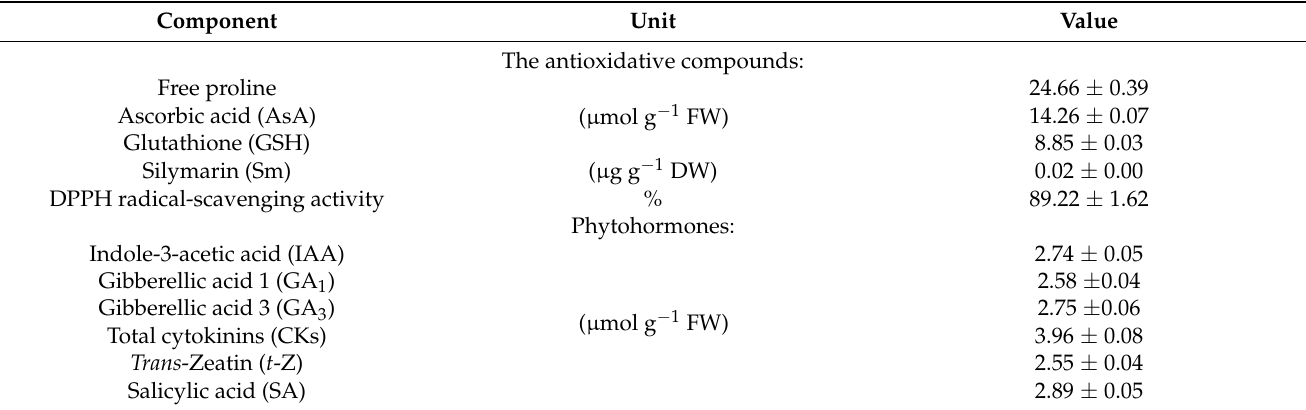
Table 3. The antioxidant and hormonal contents in maize grain extract (MEg).